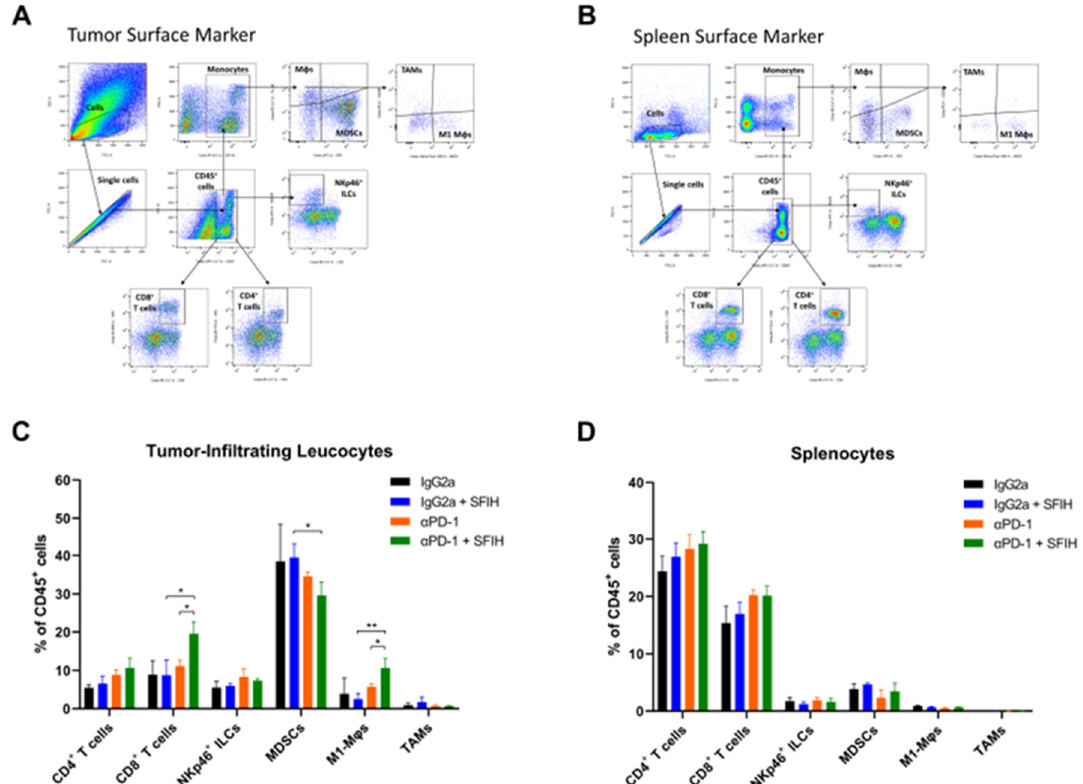
Figure 5. SFIH combined with an anti-PD-1 promoted antitumor immune response of cytotoxic T lymphocytes and M1-like macrophages in MC38 tumor-bearing mice. ( A , B ) Gating strategy for flow cytometry analysis of tumor-infiltrating CD45 + leucocytes in tumor tissues ( A ) and spleens ( B ). ( C , D ) The subset of tumor-infiltrating lymphocytes, including T cells and NKp46 + ILCs, and tumor-infiltrating monocytes, including MDSCs, M1-like macrophages, and TAMs in tumor tissues ( C ) and spleens ( D ). Error bars represent SD. p -values were determined using a two-tailed Student’s t test (* p < 0.05 and ** p < 0.01, compared to the combination group). ILCs, innate lymphoid cells; M1-M ϕ s, M1-like macrophages; TAMs, tumor-associated macrophages; MDSCs, myeloid-derived suppressor